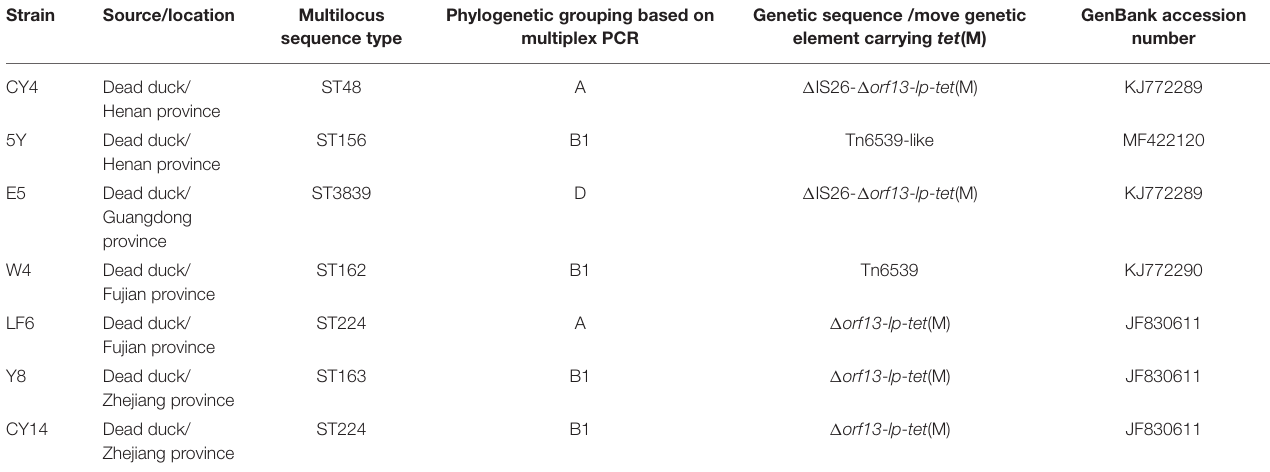
TABLE 1 | Bacterial strains used in this study.